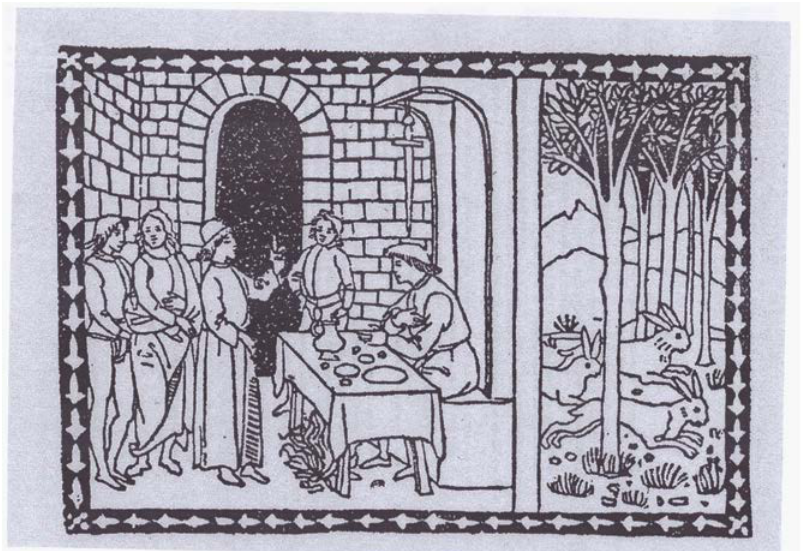
Figure 17 – Bernardo Pulci, La Rapresentatione divota di Barlaam et Iosafat , s.n.t. [but Firenze, Miscomini, around 1495], f. a3r (BNCF, Banco Rari 189.e). By permission of Ministero per i beni e le attività culturali / Biblioteca Nazionale Centrale.